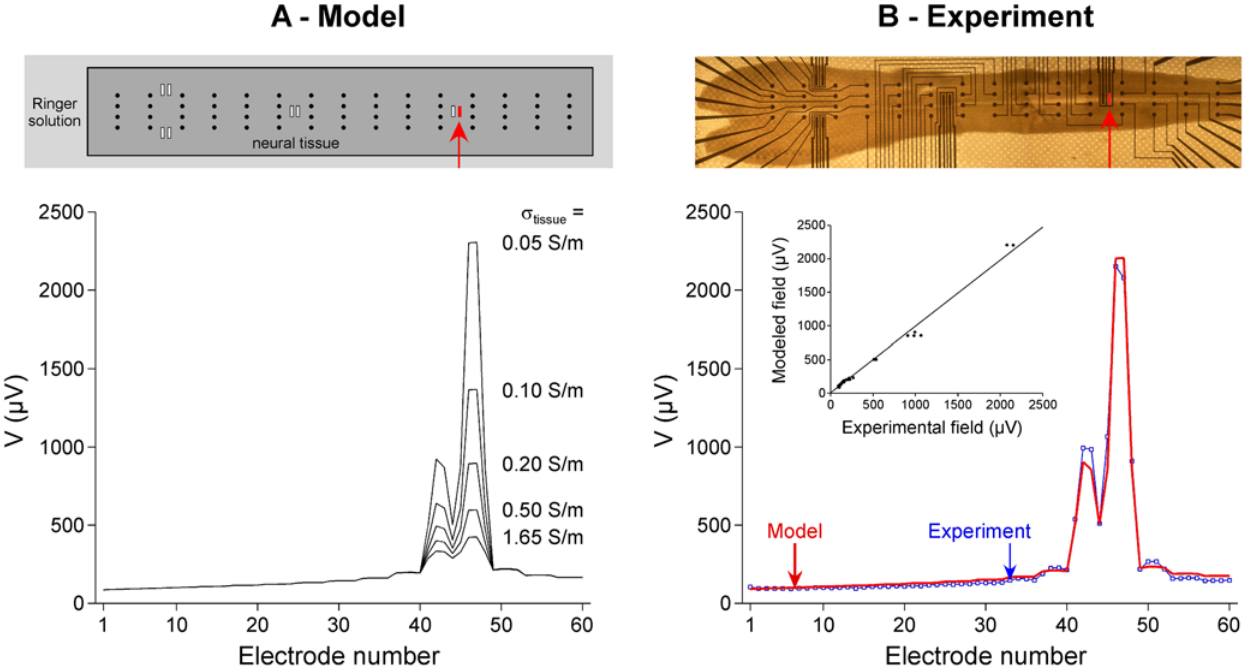
Figure 7. Influence of a neural tissue on the modeled (A) and experimental (B) potential fields. Current-controlled monopolar stimulations were delivered to the tissue (1 m A). A , Top : Top view of the finite element model including a neural tissue surrounded by the Ringer solution. Bottom : The potential field was computed for different values of the electrical conductivity s tissue of the neural tissue, while the conductivity of the Ringer solution remained unchanged ( s Ringer =1.65 S/m). B , Top : Inverted-microscope photograph of a hindbrain-spinal cord preparation on the MEA. Bottom : Experimental potential field distribution in the presence of a hindbrain-spinal cord preparation (square symbols), and modeled potential field (red curve) obtained with the finite element model equipped with Robin BCs. In this case, the surface conductances of the stimulation and ground electrodes ( g stim and g ground ) and the tissue conductivity s tissue were estimated to optimize the fit between modeled and experimental fields (R 2 =0.989, p , 0.0001). The estimated value of s tissue was 0.057 S/m.